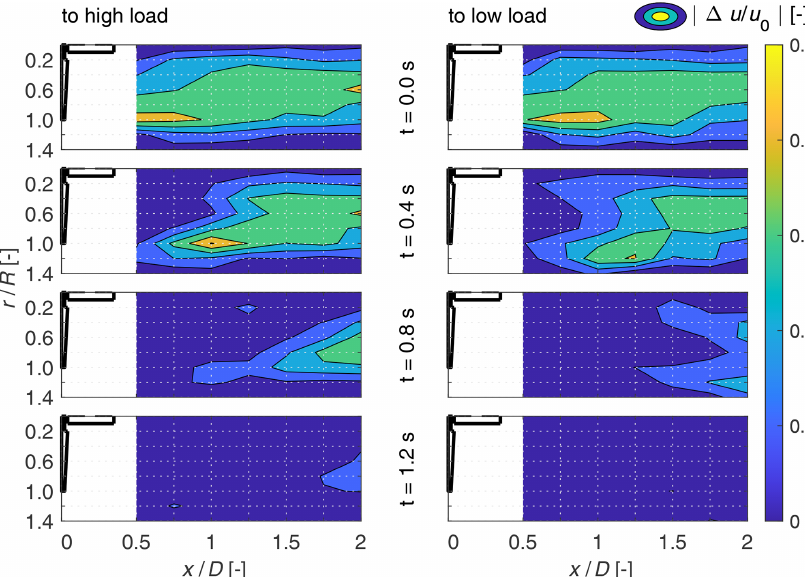
Figure 16. Top view on velocity contour in the horizontal plane at hub height of the difference to the new steady wake equilibrium at the four different timestamps 0, 0.4, 0.8 and 1.2s after the pitch steps to high and to low load, normalised by the free stream velocity. The turbine dimensions are indicated in correct scale in the plots as a reference, with the x axis being the axis of